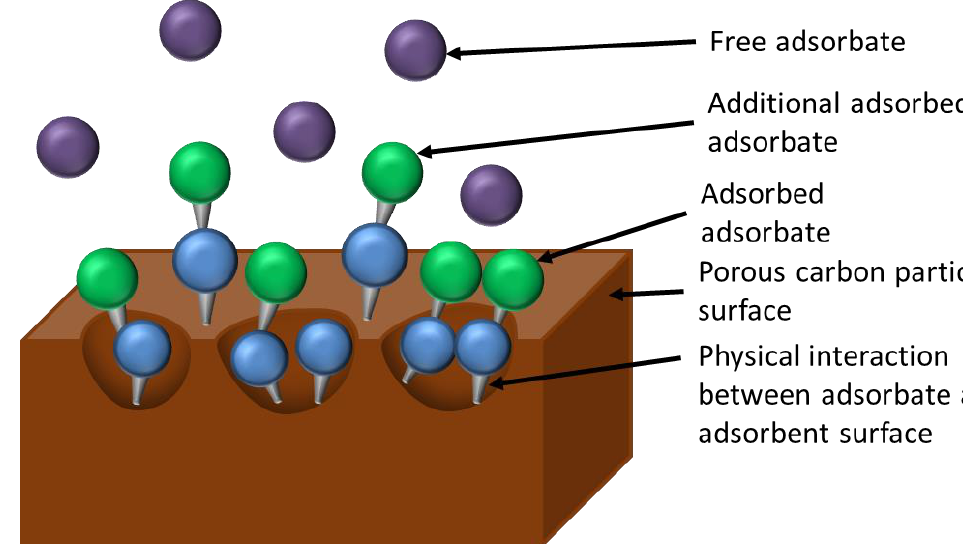
Fig. 6. Illustration of the adsorption profile in the porous